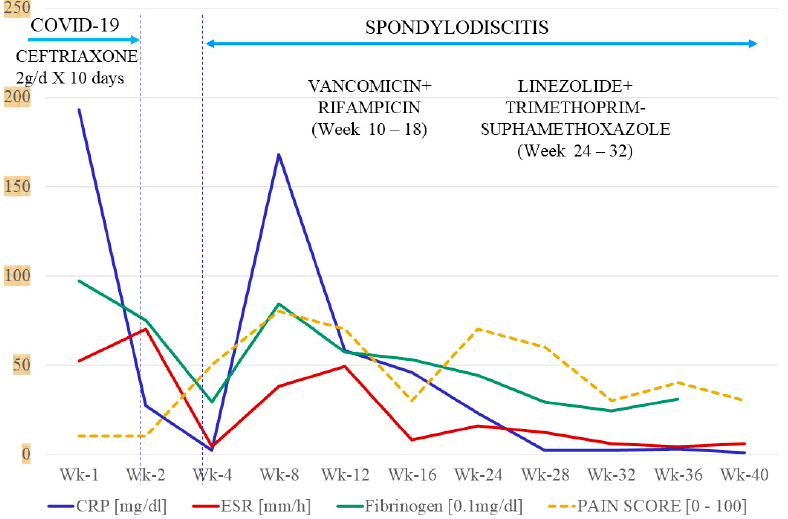
Figure A2. The sequential values of inflammatory markers and the pain score during post-COVID-19 spondylodiscitis. Table A1. Lab results during hospitalization for severe Covid-19 in a 45-years old man patient.